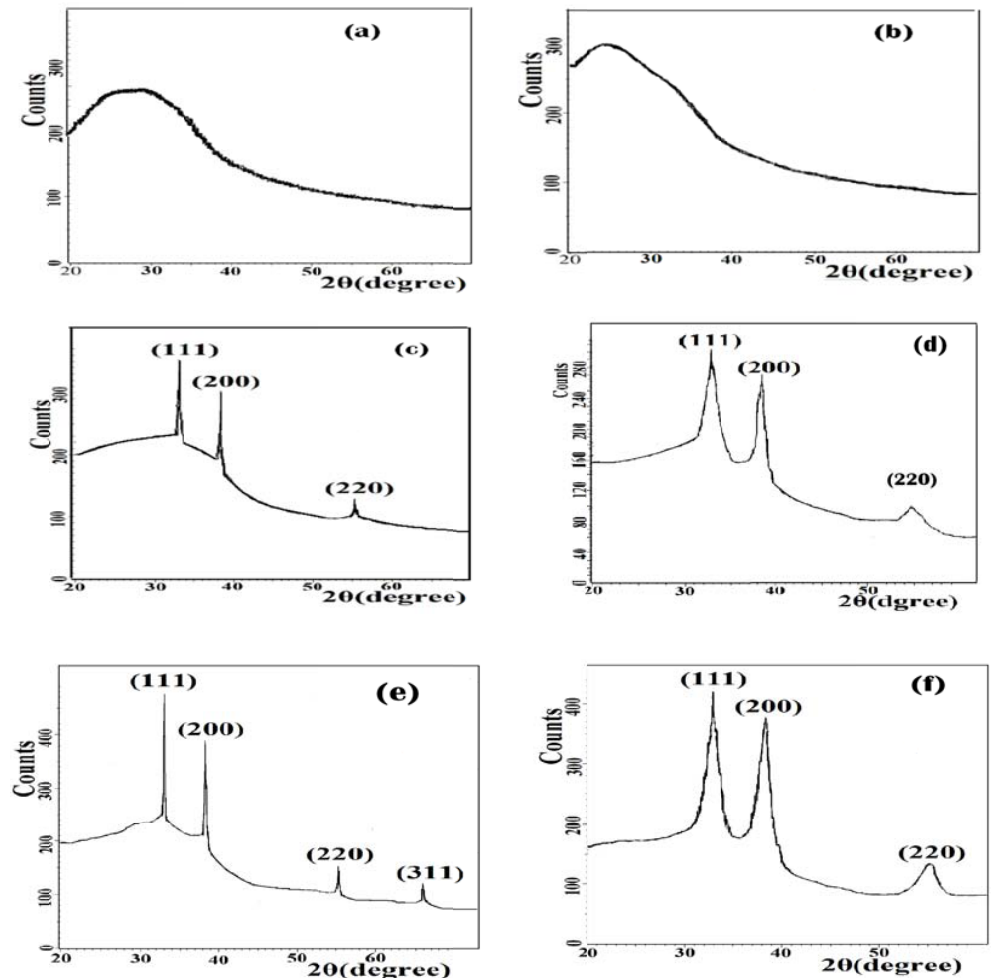
Fig. 1: X-ray (b) 300